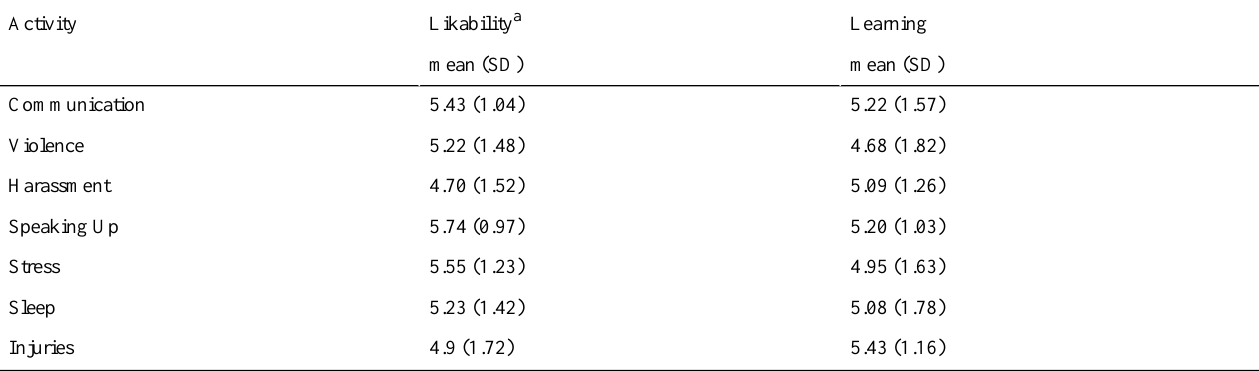
Table 2. Mean likeability and perceived